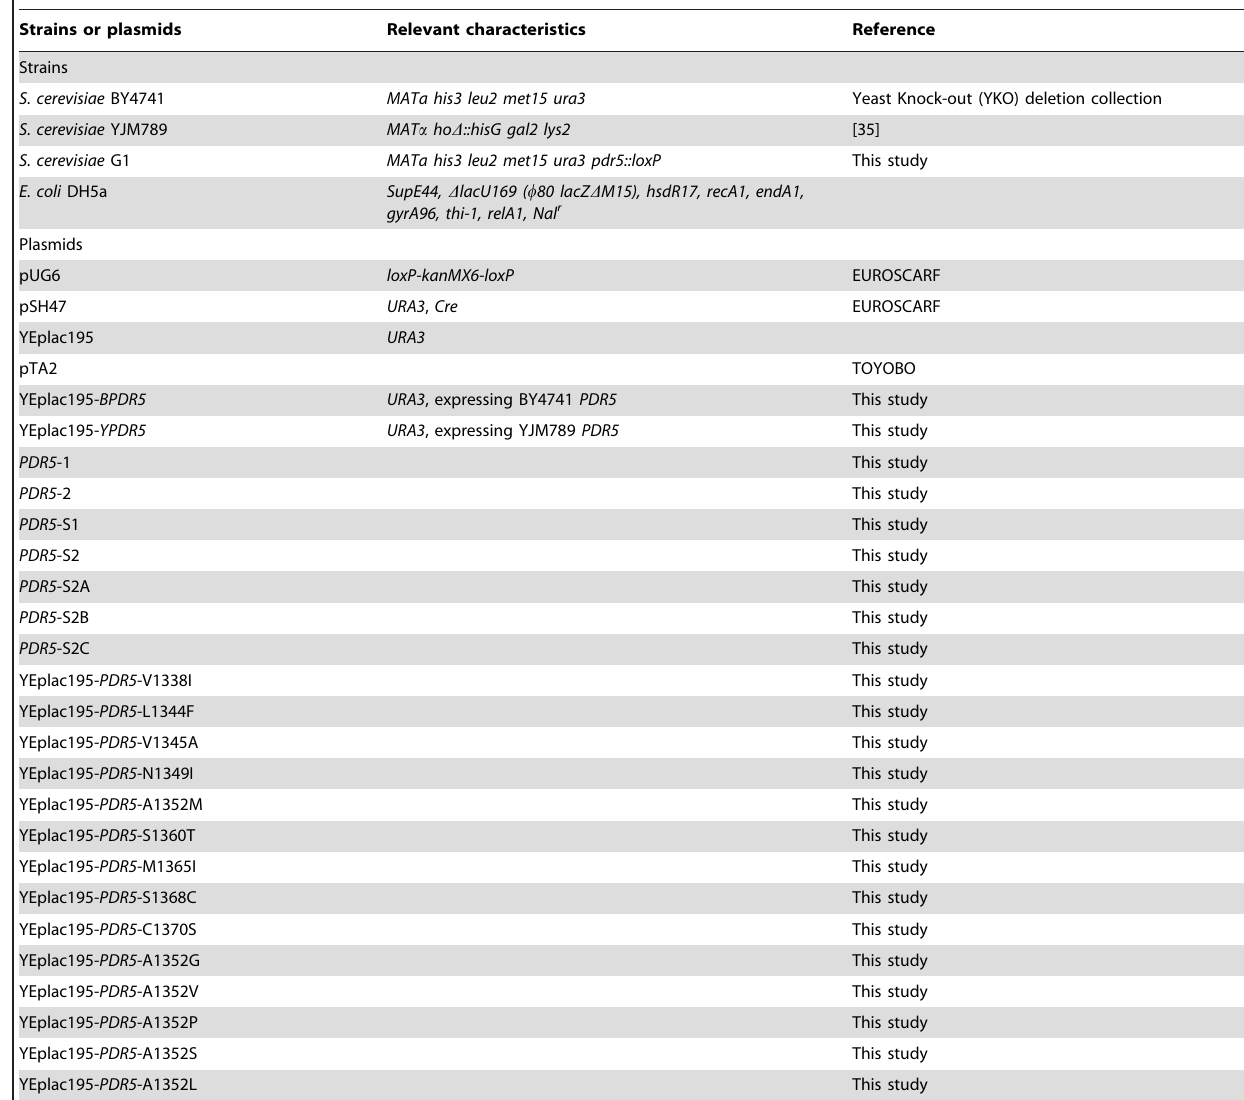
Table 1. Strains and plasmids.